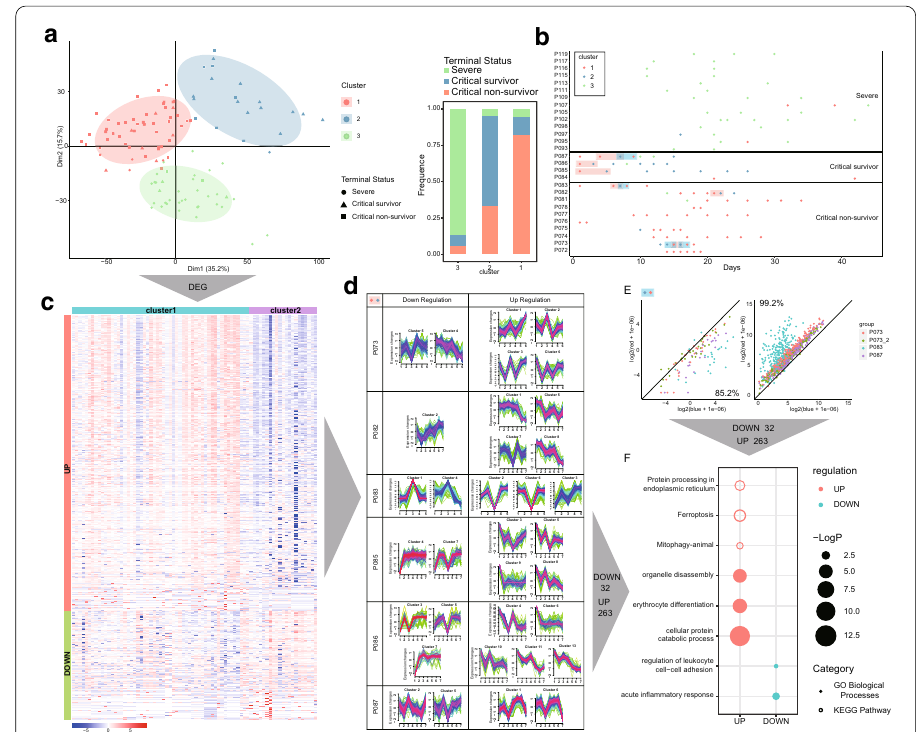
Fig. 2 Transcriptome features of phase transition between Cluster 1 and Cluster 2. a Left, PCA map for transcriptomics of 113 samples; right, the percentage of terminal status in each cluster. Dots represent samples. Three colors represent three clusters. Round, triangle, and square shapes represent patients’ terminal status. b Longitudinal distribution of samples in colors of clusters. 113 transcriptomic data were represented at time-points. Scatter plot shows the RNA sample collection time with dots colored by clusters. Red box-shadow represents Cluster 1-to-2 transition. Blue box-shadow represents Cluster 2-to-1 transition. c Heatmap of differential expression genes (logFC > 1) between Cluster 1 and Cluster 2. d Soft clustering of longitudinal gene dynamics in six patients containing Cluster 1-to-2 transition (FDR < 0.05). Each patient is individually analyzed by using mfuzz. X-axis represents the sampling time. e Validation of differential expressed gene from Cluster 1-to-2 by using Cluster 2-to-1 transcriptome data. Color represents the patient id. 85.2% up-regulated genes and 99.2% down-regulated genes show reversed expression levels. f GO terms and KEGG pathways for differentially expressed genes between Cluster 1 and Cluster 2. Top 3 terms and pathways are displayed. The size of dots denotes the -log 10 of the p-value, the color denotes the expression